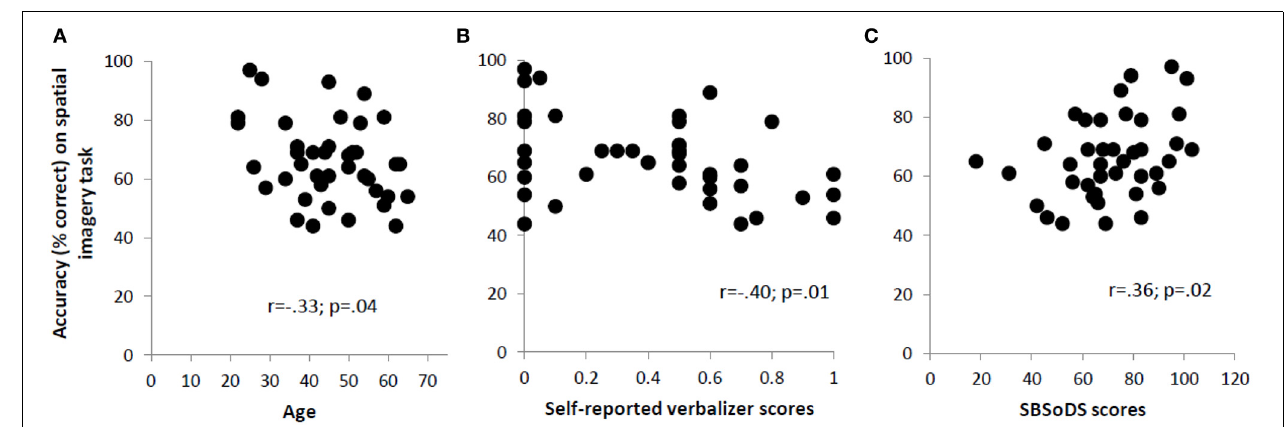
FIGURE 3 | Significant correlations across all participants between accuracy on the spatial imagery task and (A) age, (B) self-reported verbalizer scores, and (C) SBSoDS scores.